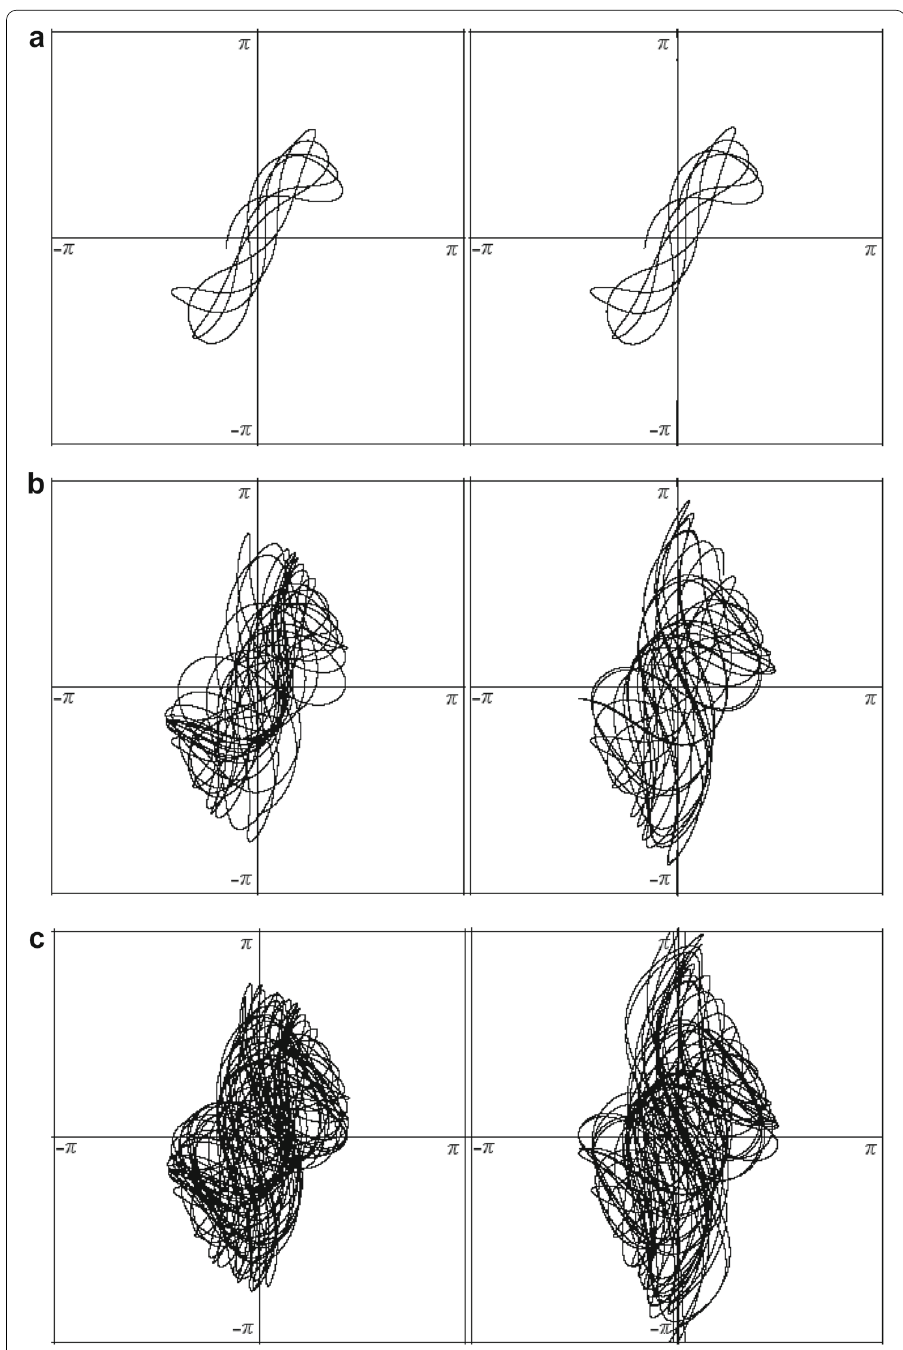
Fig. 10 Double pendulum: Comparison of dynamics. Left: Dirac-2, right: explicit Euler. Region swept by the trajectory until a T = 10, b T = 50 and c T = 100